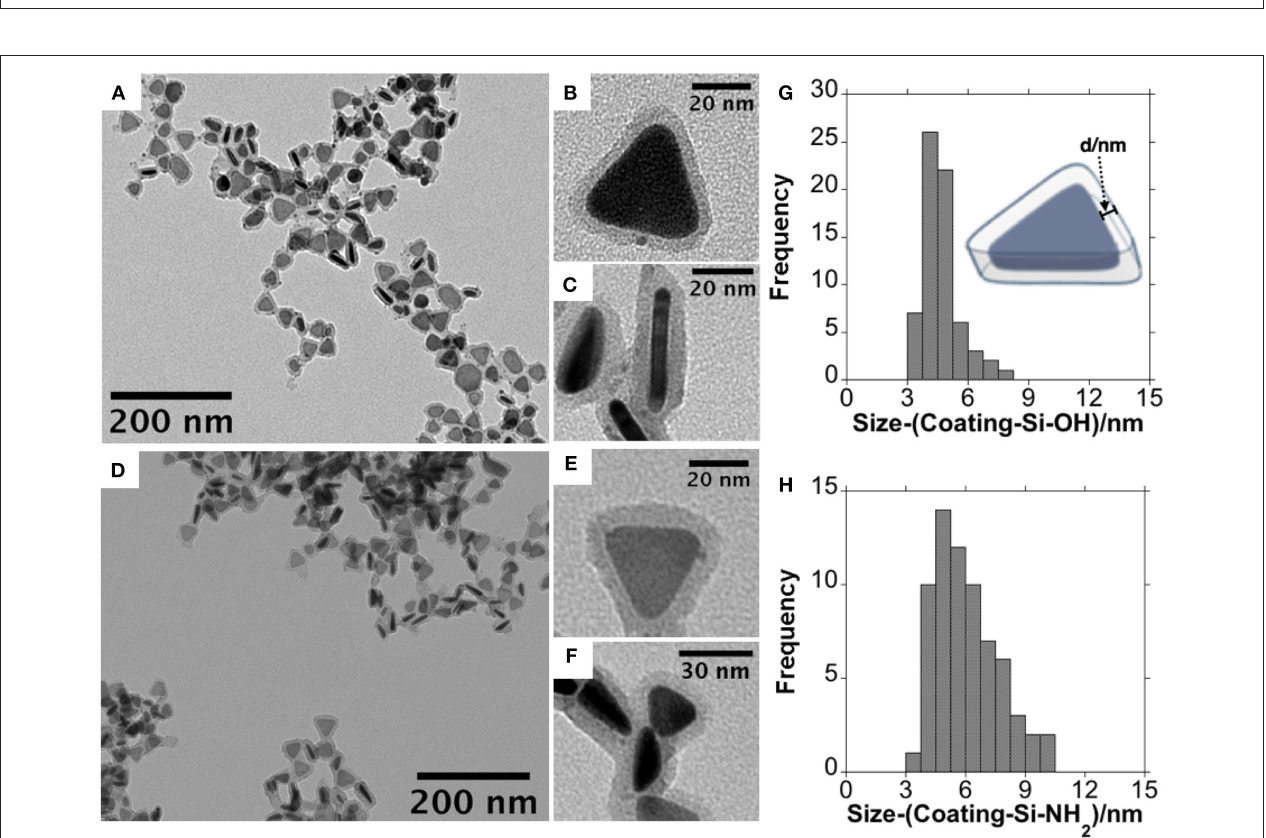
FIGURE 4 | Low magnification TEM images at different magnifications obtained for AgNTs@Si-OH (A–C) and AgNTs@Si-NH 2 (D–F) and size histogram of silica coating for AgNTs@Si-OH (G) and AgNTs@Si-NH 2 (H) .